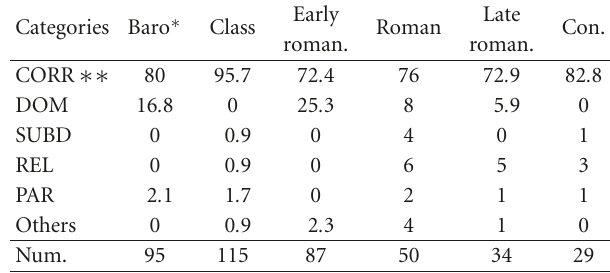
Table 1: Results analysis of global key answers across periods ob- tained from fuzzy analysis technique and CEG